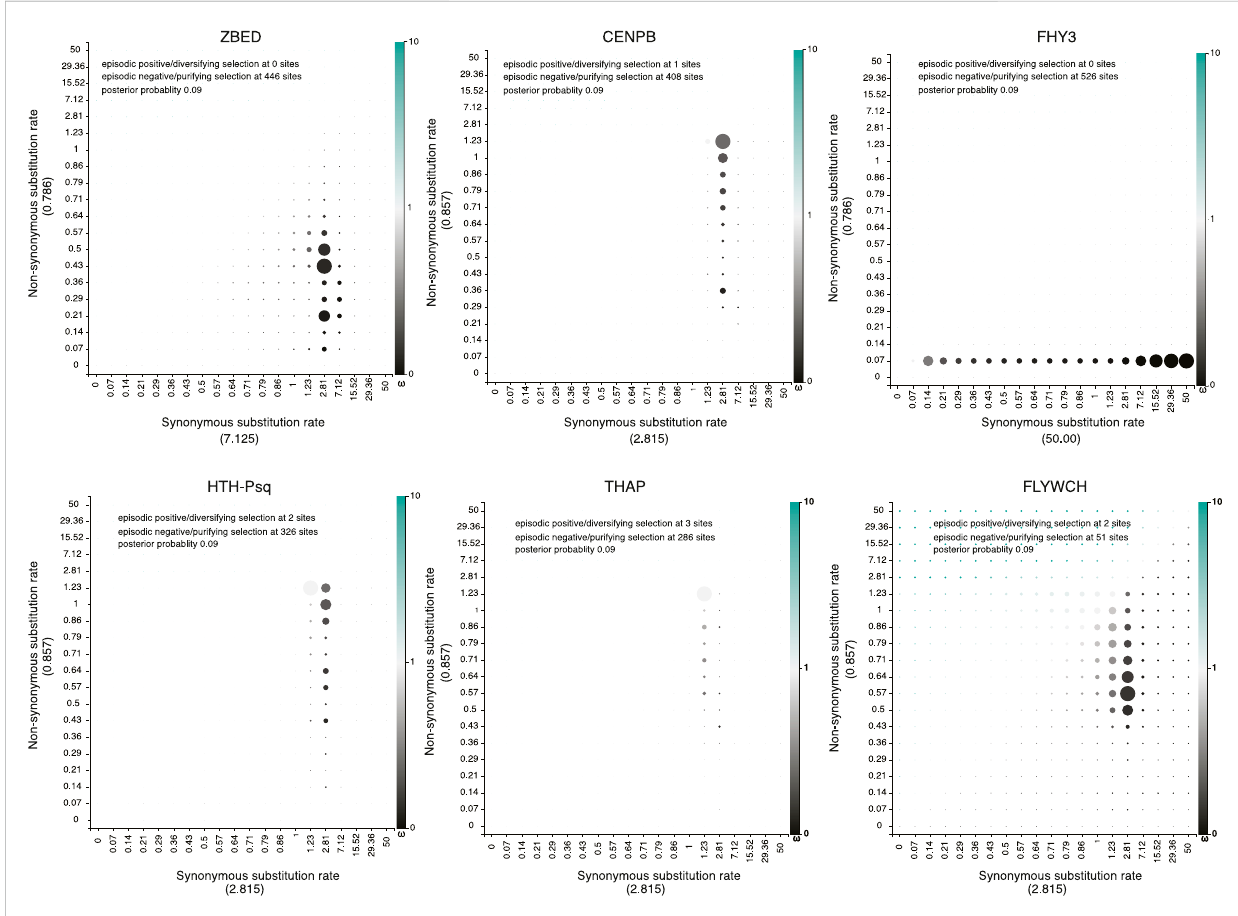
FIGURE 4 Non-synonymous (dN) versus synonymous substitution (dS) ratio show transposon-derived transcription factors evolving under purifying selection pressure. Non-synonymous versus synonymous substitutions were calculated across all potentially TE-derived TF families using the Fast Unbiased Bayesian Approximation (FUBAR) approach (Murrell et al., 2013). Synonymous substitutions (dS) rates calculated under each family are shown in X -axis insidetheparentheses.Similarly,Non-synonymoussubstitutions(dN)ratescalculatedundereachfamilyshowedintheYaxisinsidetheparentheses. Gray to intense black color-coding dots signi fi es negative or purifying (dN/dS < 1) selection, while light green to intense green represents sites under diversifying or positive (dN/dS > 1)